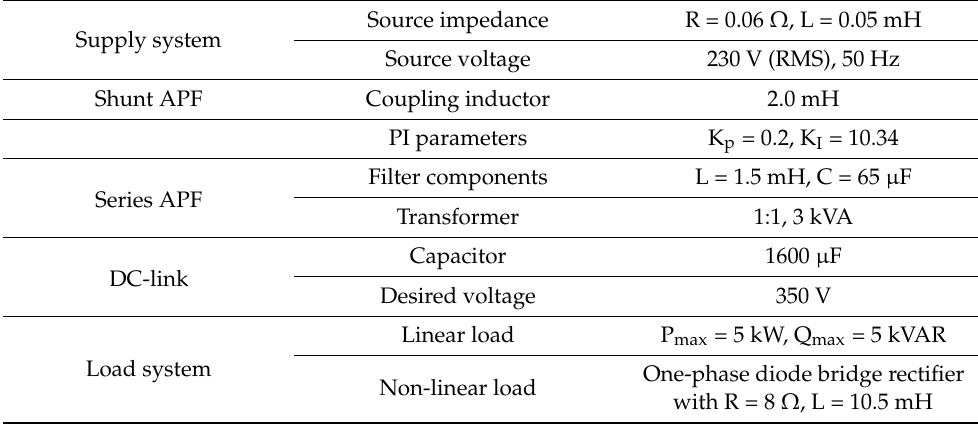
Table 1. Parameters for simulation and real ‐ time analysis.